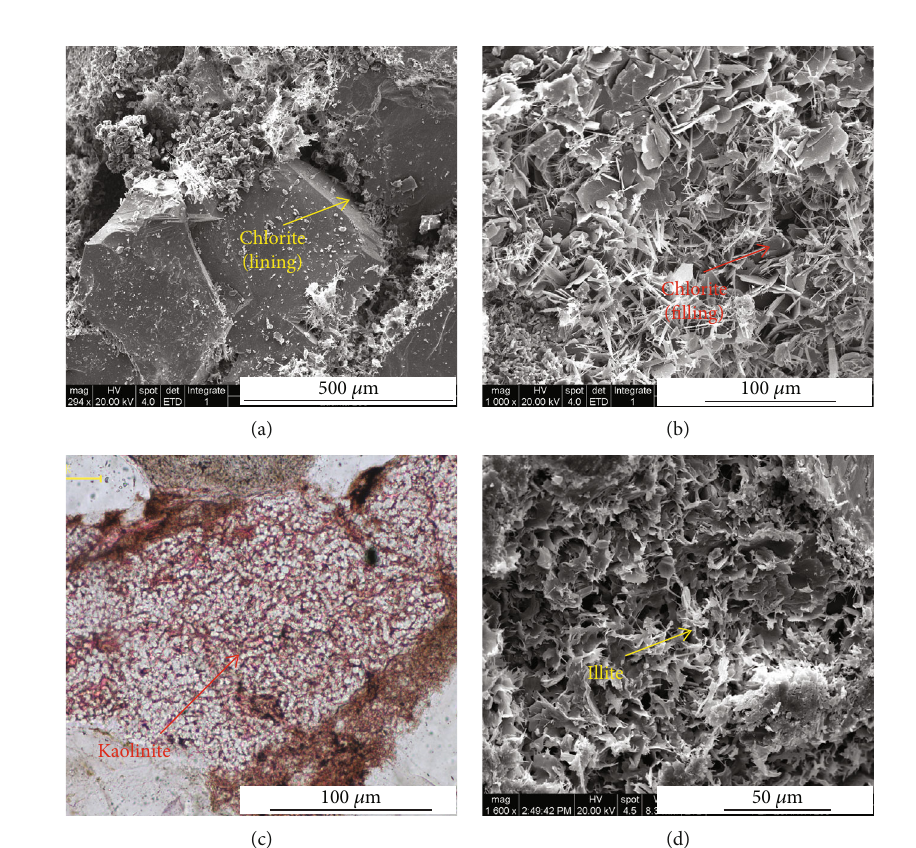
Figure 8: Representative thin section and SEM images to reveal the microscopic